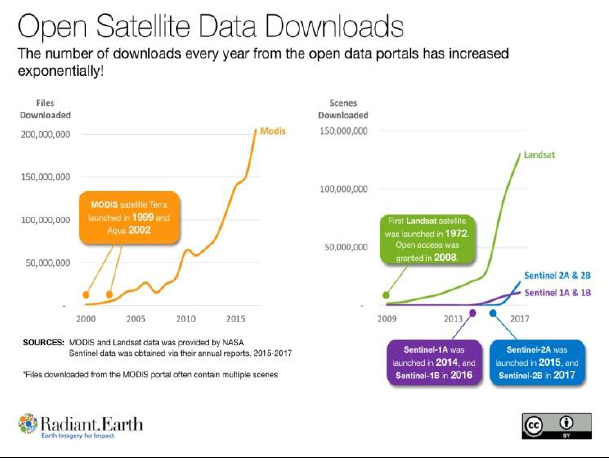
Fig 3 Increase in open satellite data